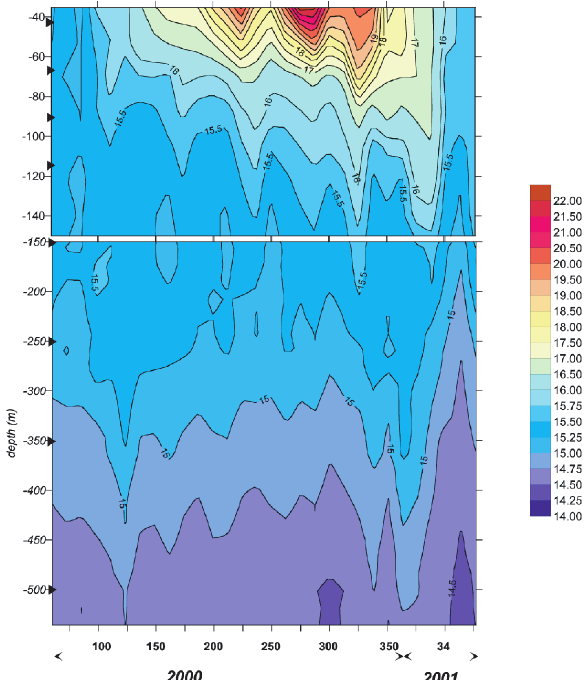
Fig. 3. Time/depth diagram of the temperature (deg. C) for one year of measurements. Position of the instrument is shown by a